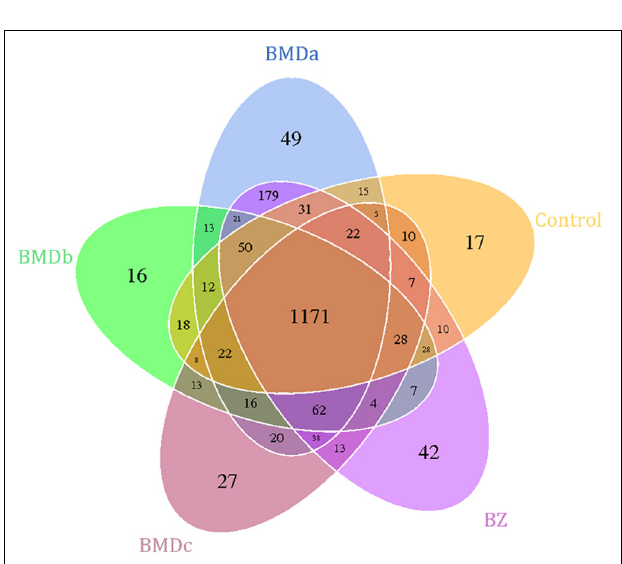
FIGURE 4 | Shared operational taxonomic unit (OTU) analysis of the different groups. Each circle in the figure indicates a group, and the numbers in the circle and circle overlap represent the number of OTUs between the groups. The number not in overlap indicates the number of unique OTUs in the